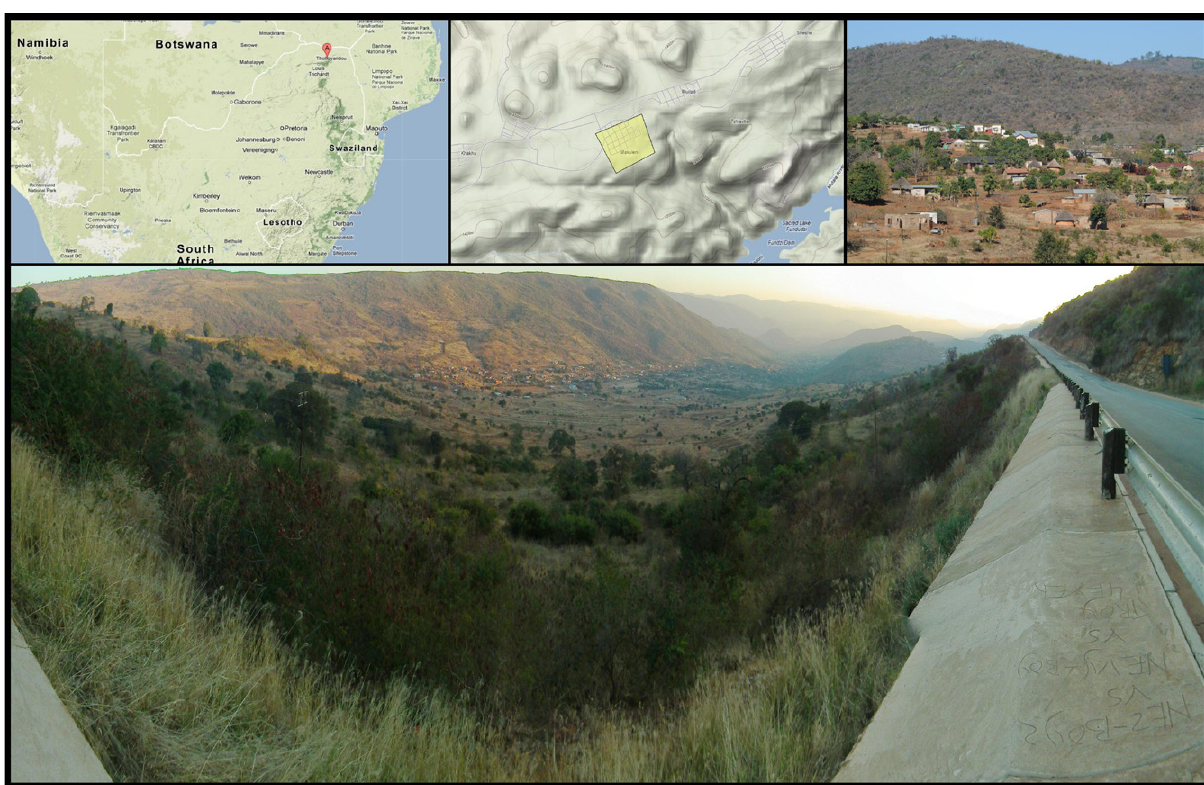
Figure 3: Overview of the Siloam Valley and Makuleni Village: the site of the hypothetical enhanced geothermal